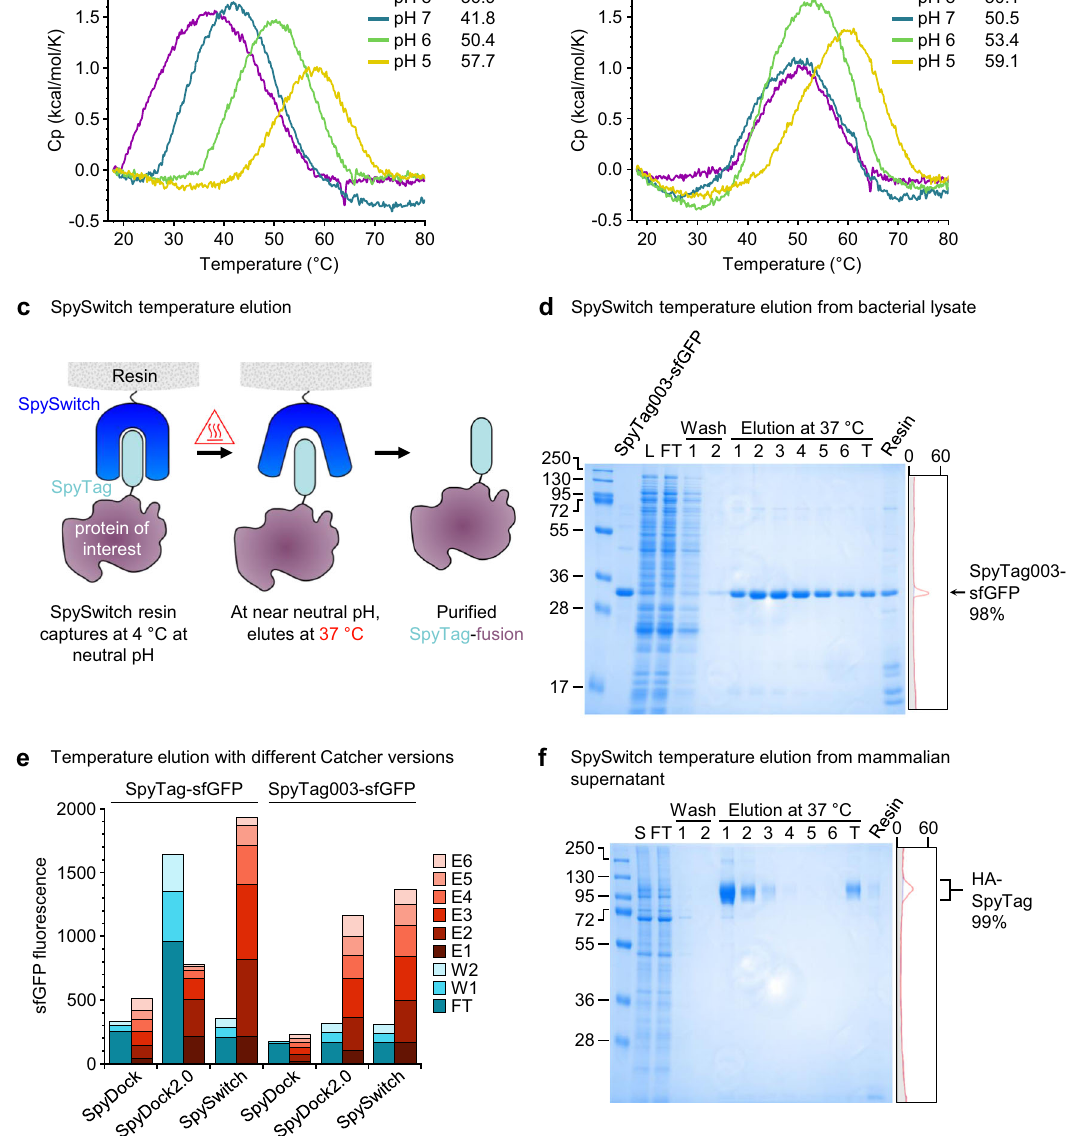
Fig. 4 Temperature-dependence in SpySwitch. a DSC of SpySwitch at pH 5.0, 6.0, 7.0 or 8.0 in succinate-phosphate-glycine (SPG) buffer. Melting temperature (T m ) is given at each pH. b DSC for SpyDock as in ( a ). c Overview of temperature-based elution. SpyTag interacts with SpySwitch at 4 °C and is eluted at 37 °C. d Reducing SDS-PAGE performed for SpySwitch temperature elution of SpyTag003-sfGFP from bacterial lysate, with capture at 4 °C and elution at 37 °C (pH 8.0). L, doped lysate; FT, fl ow-through; T, total pooled elution fractions; Resin, protein left on resin following elution. On the right of the gel is the trace from densitometry of lane T (gray, background; orange, bands) plotted by intensity, with percent purity shown. e SpySwitch and SpyDock2.0 but not SpyDock allow temperature elution. SpyTag-sfGFP or SpyTag003-sfGFP was captured by SpyDock, SpyDock2.0 or SpySwitch and eluted by 37 °C incubation at pH 8.0. Fluorescence was determined from fl ow-through (FT), wash (W), or 37 °C elution (E) fractions ( n = 1). Fluorescence in arbitrary units was multiplied by the volume of the fraction, to give arbitrary units*mL. f SpySwitch temperature elution of HA bearing a C-terminal SpyTag from mammalian Expi293F expression, assessed by reducing SDS-PAGE/Coomassie. S, supernatant; FT, fl ow-through; T, total pooled elution fractions; Resin, protein left on resin following elution. Molecular weight markers represent kDa. Source data are provided as a Source data fi impact on purity of SpyTag-sfGFP was observed, while maximum recovery decreased by 28% from 15.8 mg per mL resin for fresh resin (after 7 months storage in 20% ethanol) to 11.4 mg per mL resin after fi ve regeneration cycles (Supplementary Fig. 8 c, d).